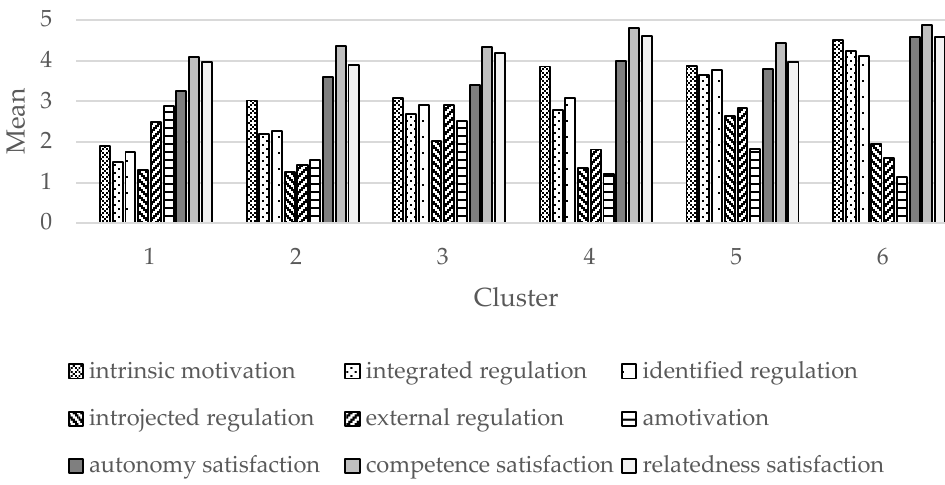
Figure 2. Overview on mean values of SOM input variables across the six clusters.